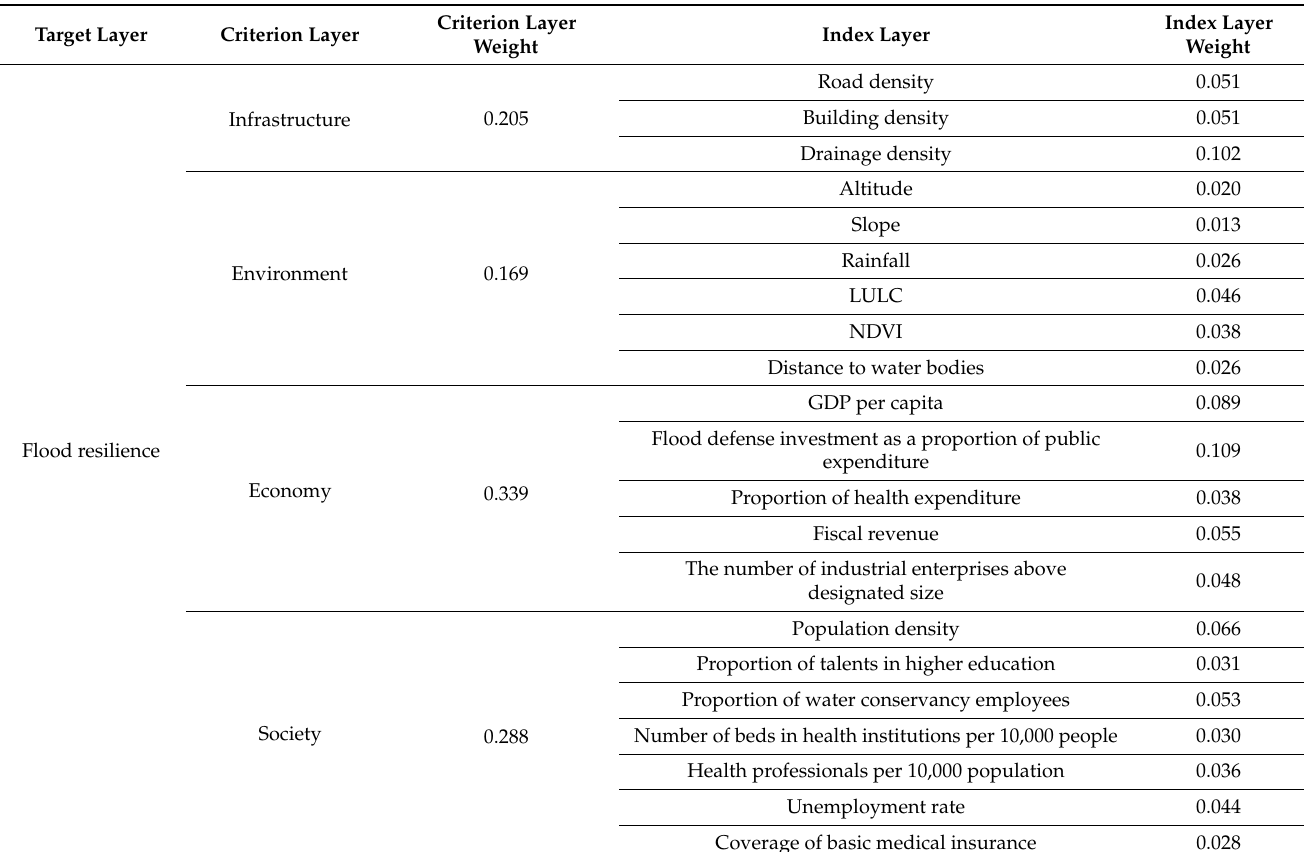
Table 5. Weight of flood resilience